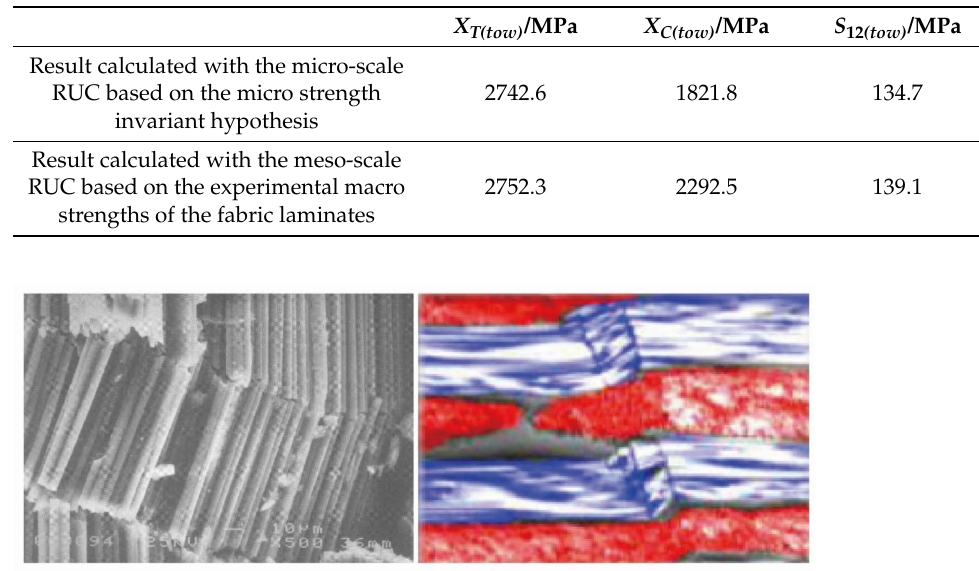
Table 9. Comparison of the meso-scale strengths of the fiber tows calculated from different methods.